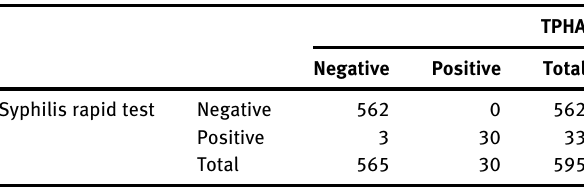
Table  : Comparison of Treponema pallidum hemagglutination assay (TPHA) and syphilis rapid test results.